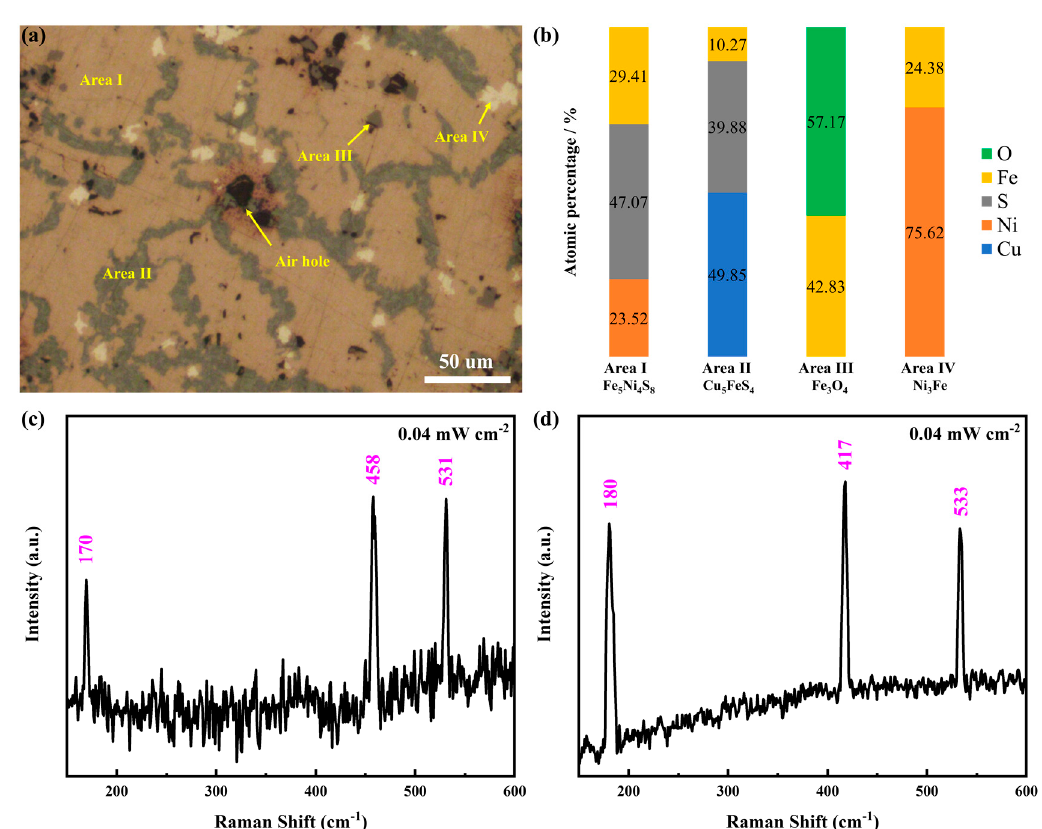
Figure 3. ( a ) OM image of the fresh surface of the low-nickel matte; ( b ) EDS analyses for the selective areas from ( a ) and ( c ) Raman spectrum of the Cu 5 FeS 4 regions at the fresh surface; ( d ) Raman spectrum of the Fe 5 Ni 4 S 8 region at the fresh